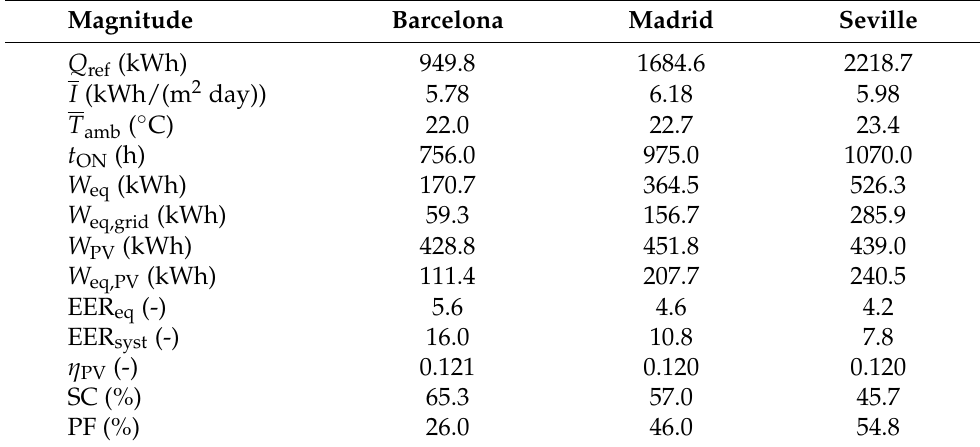
Table 3. Results concerning the influence of the climatic region analysis.